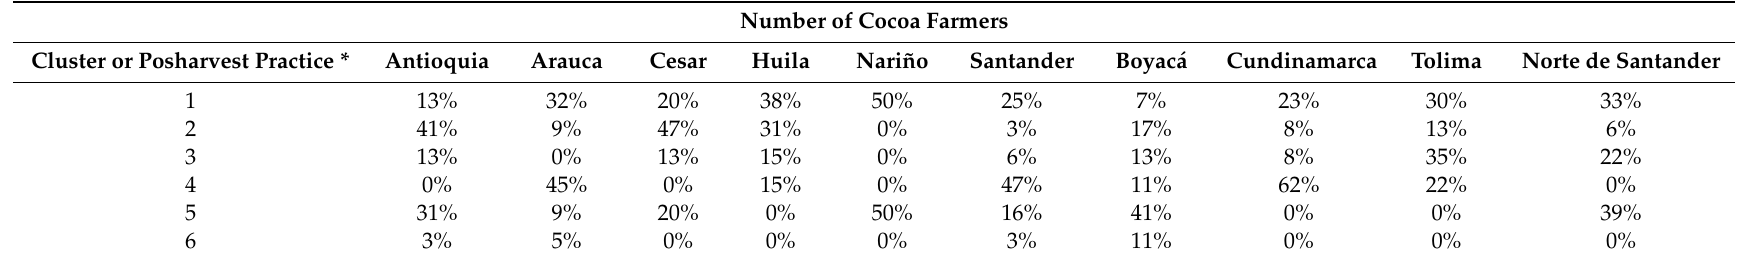
Table 2. Percentage of farmers performing di ff erent types of postharvest practices (defined by clusters) across